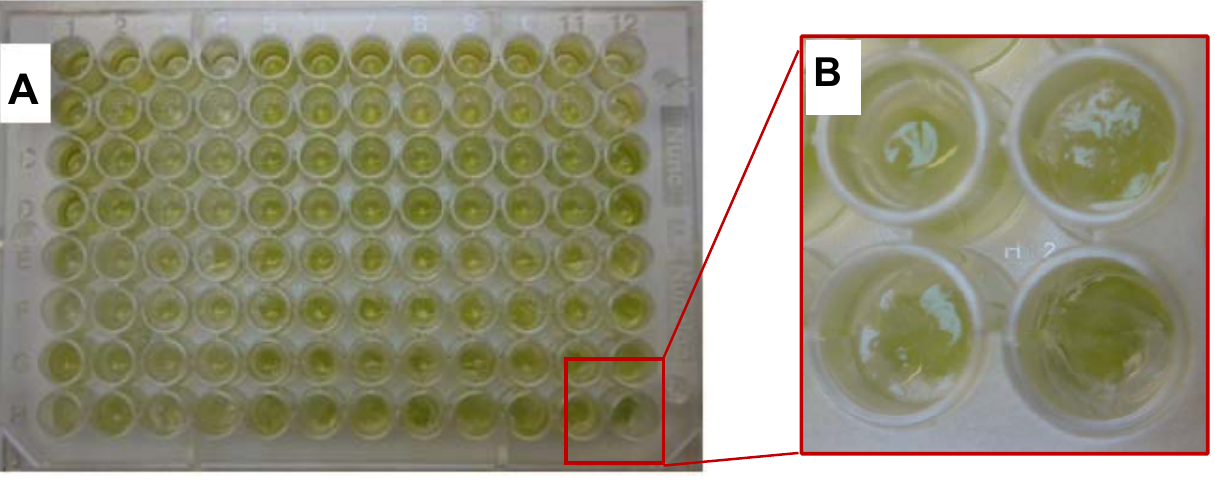
Figure 1. Photograph of the biosensor with C. reinhardti ( A ); Zoom on wells with two step-immobilized algae ( B